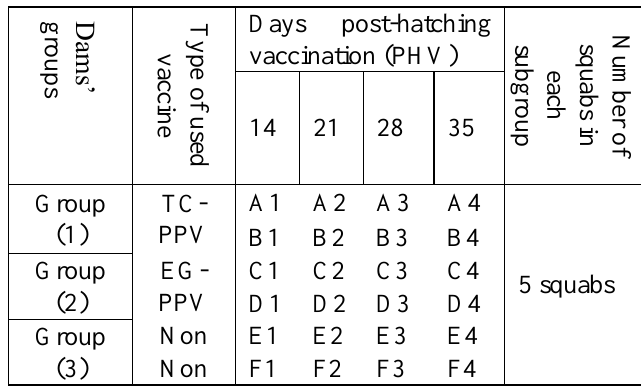
Table 1: Experimental design of squab’s